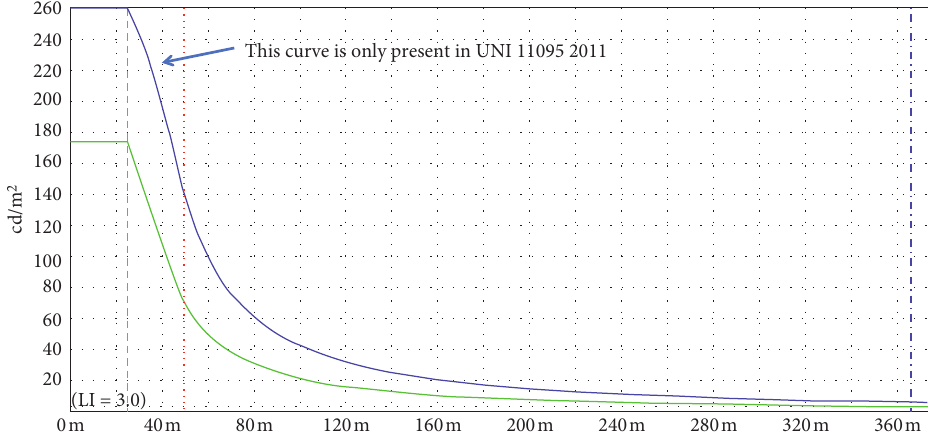
Figure 5: The luminance reduction curve, which indicates the minimum required luminance for accomplishing the standards for the trial tunnel generated by LiteStar 4D software (green curve: CIE 88:2004 standar, blue curve: UNI 11095.